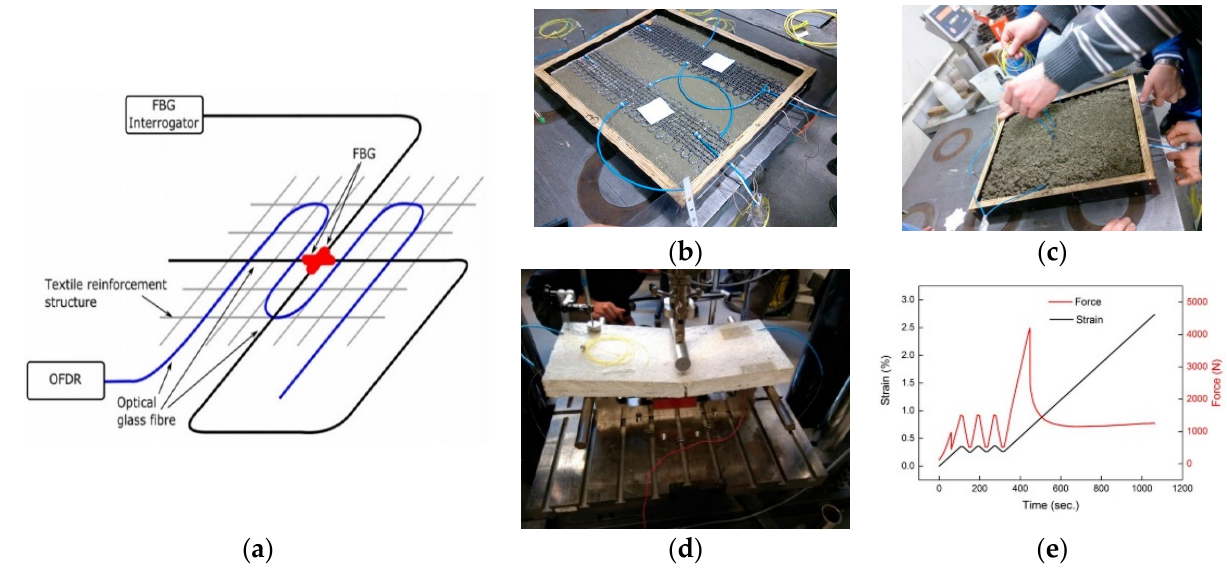
Figure 18. Experimental set-up to characterize the response of FOSs for point-based and distributed sensing ( a ), textile-based carbon reinforcement structures embedded in concrete blocks ( b , c ), the three-point-bending test ( d ), and the corresponding applied strain and force ( e ) [97].